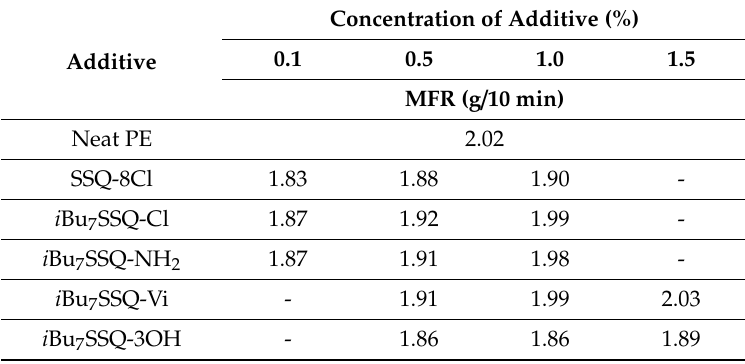
Table 6. MFR values for SSQ / PE